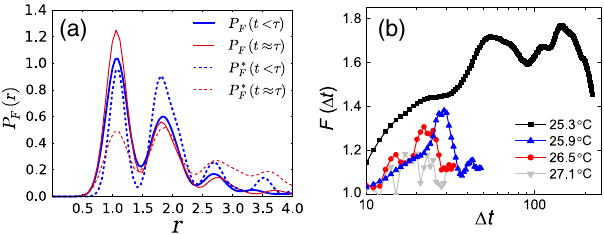
FIG. 7. Mobility propagation through facilitation. (a) The probability distributions P for two time scales ( Δ t < τ and Δ t ≈ τ ) are shown for compari- son. (b) Mobility transfer functions at different